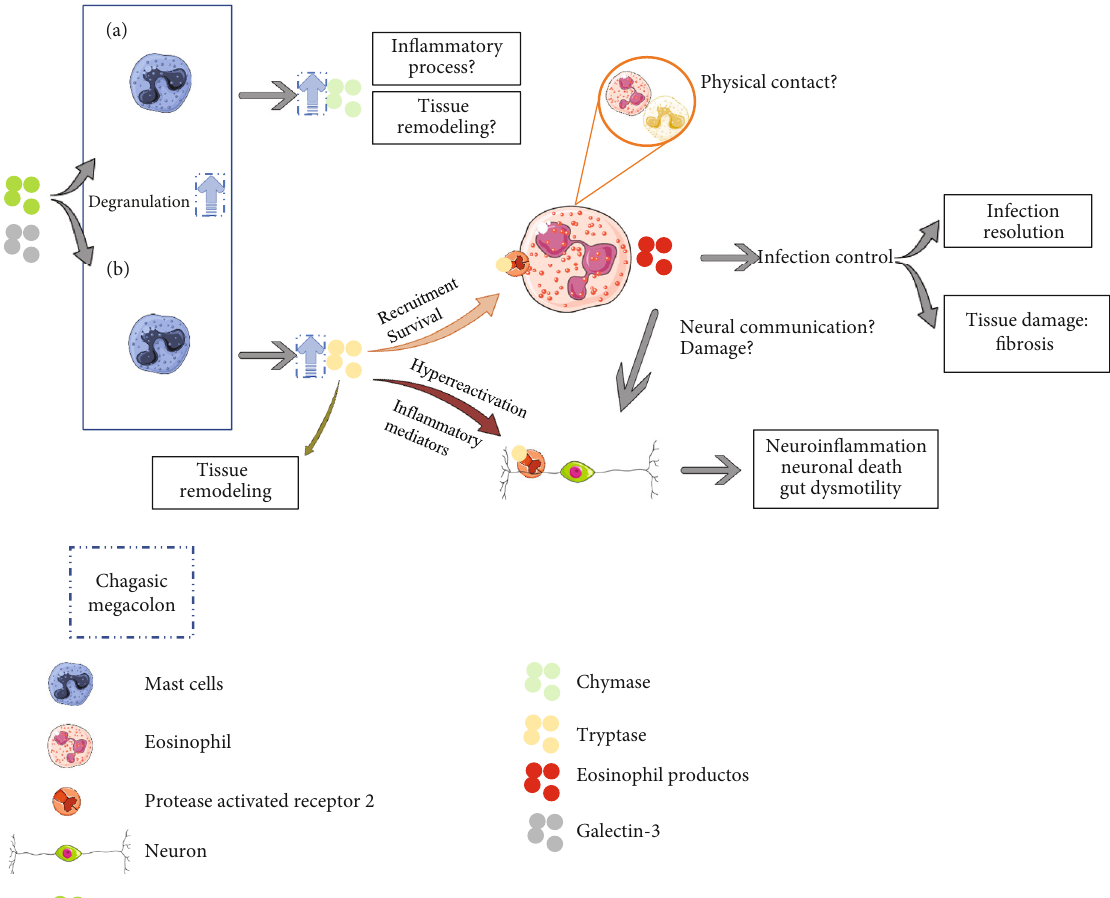
Figure 2: Possible functions of mast cells and chymase (a) and tryptase (b) proteases in Chagasic megacolon. This work, “ Possible functions of mast cells and chymase (a) and tryptase (b) proteases in Chagasic megacolon, ” is a derivative of “ Servier Medical Art ” by Servier, used under CC BY